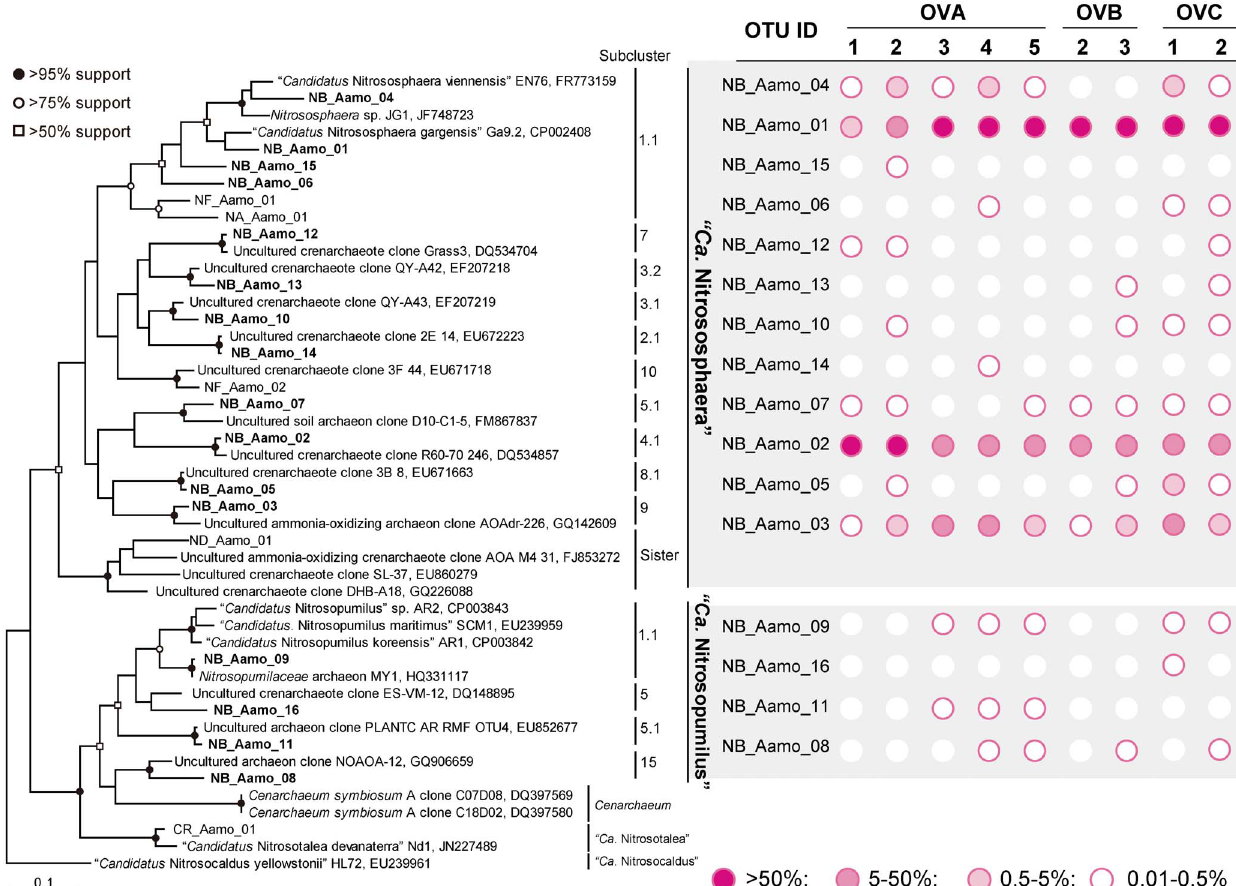
Figure 4. Distance matrix tree of archaeal amoA gene sequences retrieved from niter-bed soils based on the maximum likelihood method. Boldface indicates the sequences obtained in this study. The amoA gene sequence of the ‘‘ Ca . Nitrosocaldus yellowstonii’’ strain HL72 (EU239961) was used as outgroup. The bar indicates 10% base substitution. Branching points supported probabilities . 95%, . 75%, and . 50% by bootstrap analyses (based on 1,000 replicates, estimated using the maximum likelihood method) are indicated by solid circle, open circles, and open square, respectively.